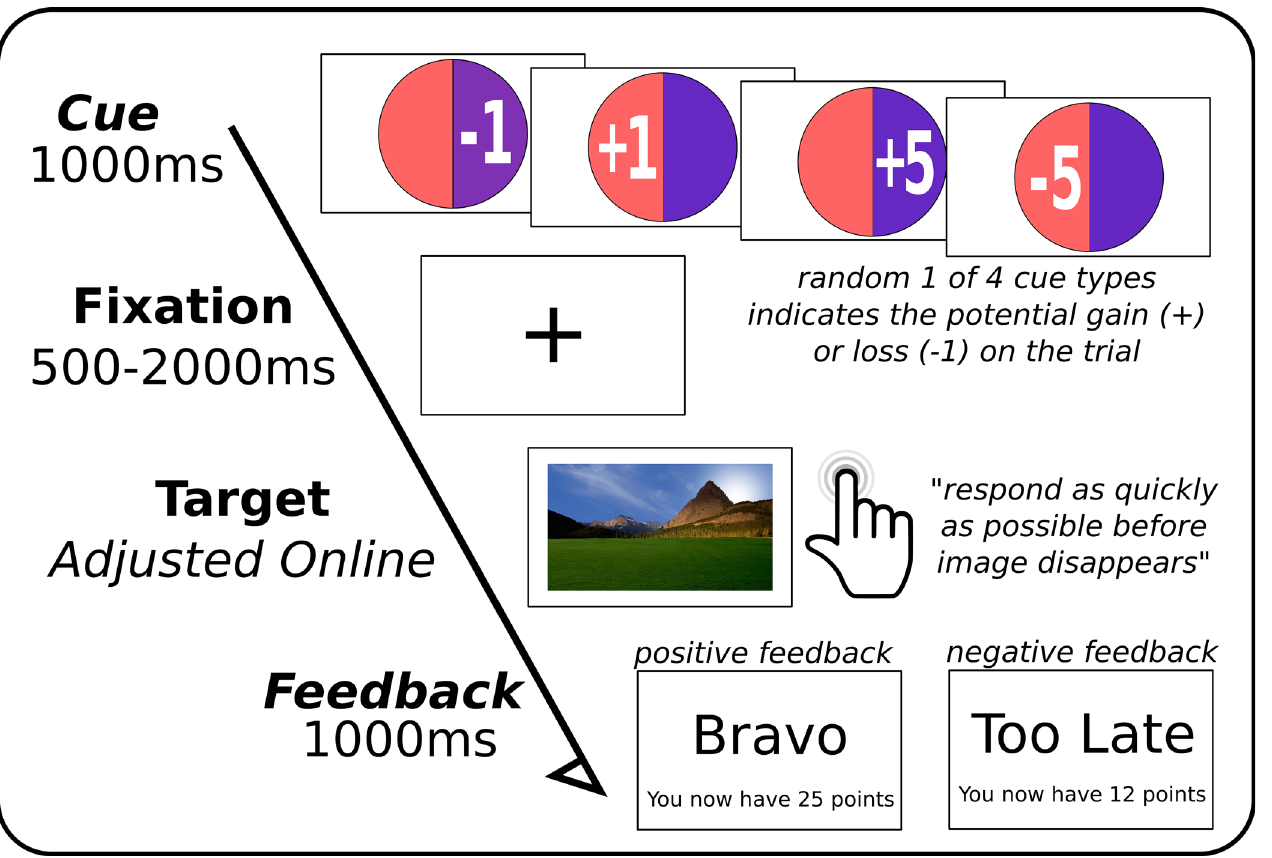
Fig 1. Overview of experimental task. One of the four possible cues appeared on the screen followed by a fixation cross for a random interval. Colour scheme was random and irrelevant for the current task. Participants were asked to press the button as quickly as possible once the landscape picture (one of a random set of ten), was presented on the screen. This was followed by a feedback display as to whether or not they were successful in the task and their current point total.